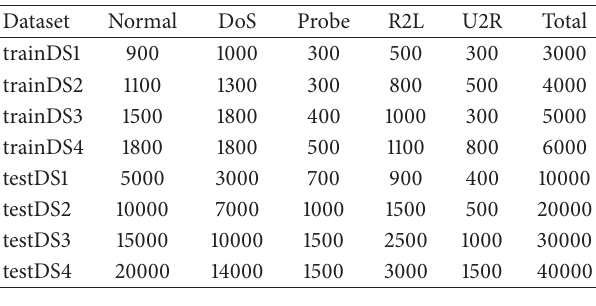
Table 1: The details of evaluation datasets.